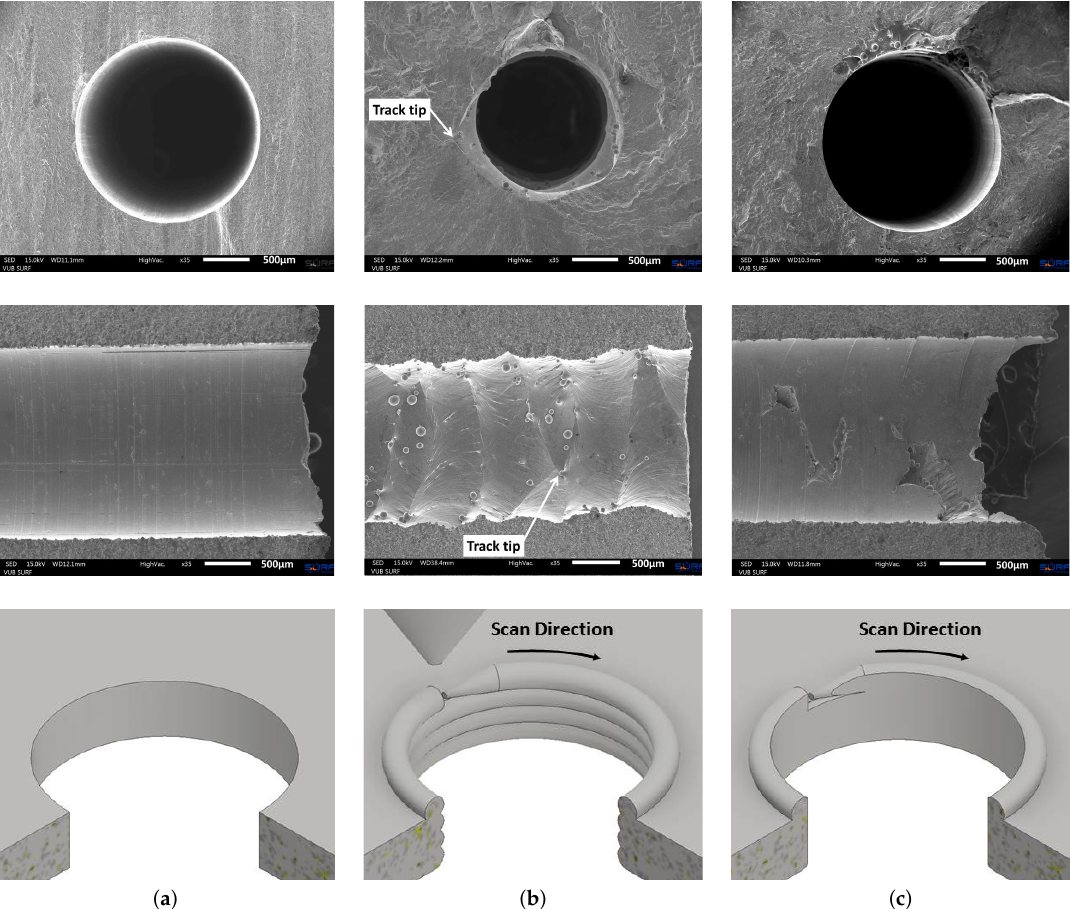
Figure 11. Cross sectional view (top), longitudinal view (middle) and CAD representation of the production process (bottom) of a ( a ) drilled capillary in wrought Ti-6Al-4V (Specimen 6), ( b ) vertically built capillary by laser based DED (Specimen 9) and ( c ) vertically built capillary by laser based DED (Specimen 9) with additional deep gun drilling (Specimen 13). The fracture surface is on the right for the middle